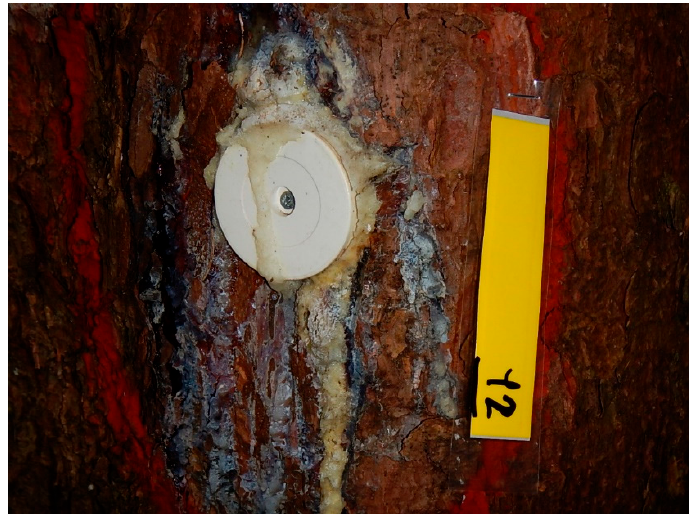
Figure 6. SY model (left) after 2 years and a newly applied SS tag over bark (right).